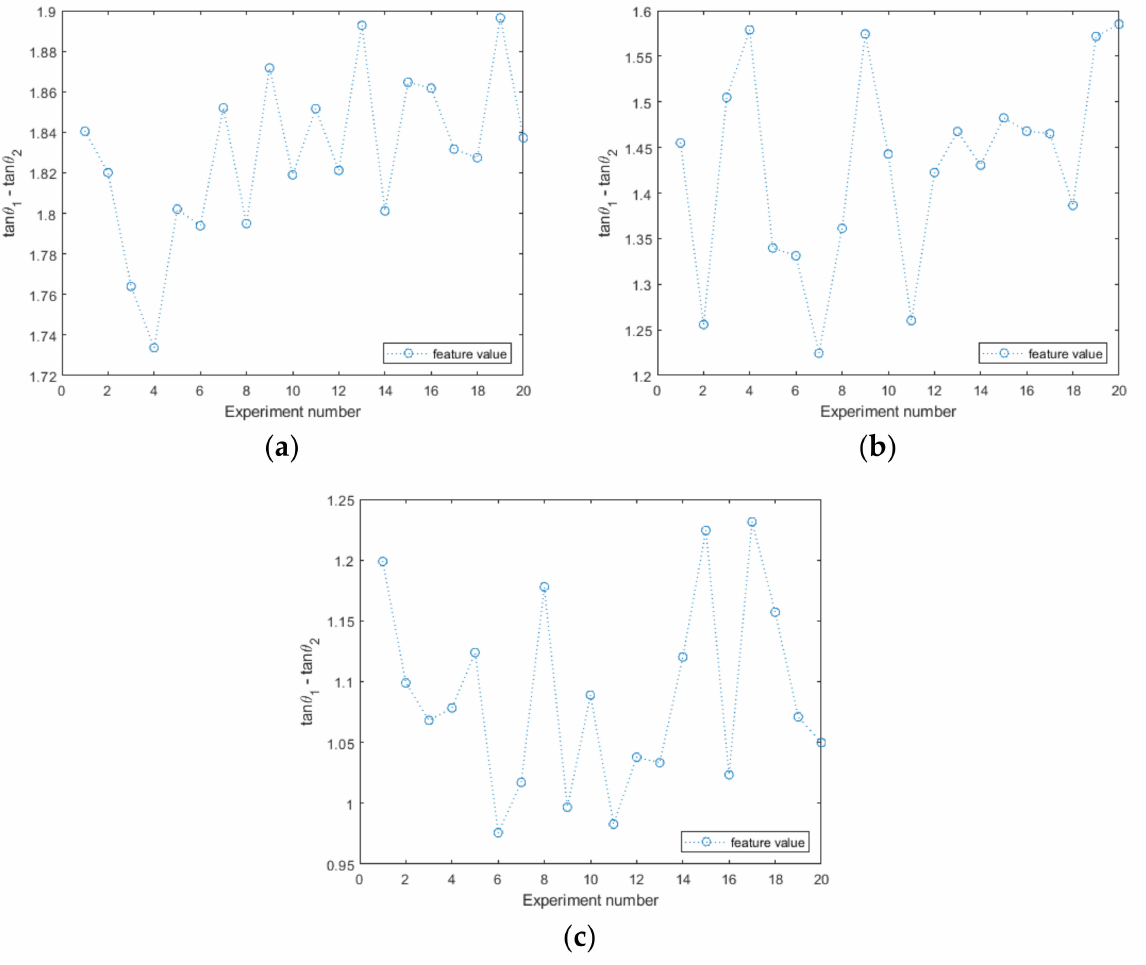
Figure 9. Mathematical statistics of feature value. ( a ) Cu, planar, lift-off = 1 mm ( b ) Al, spherical, lift-off = 3 mm ( c ) Zn, cylindrical, lift-off = 5 mm. Table 2. Mathematical statistics for